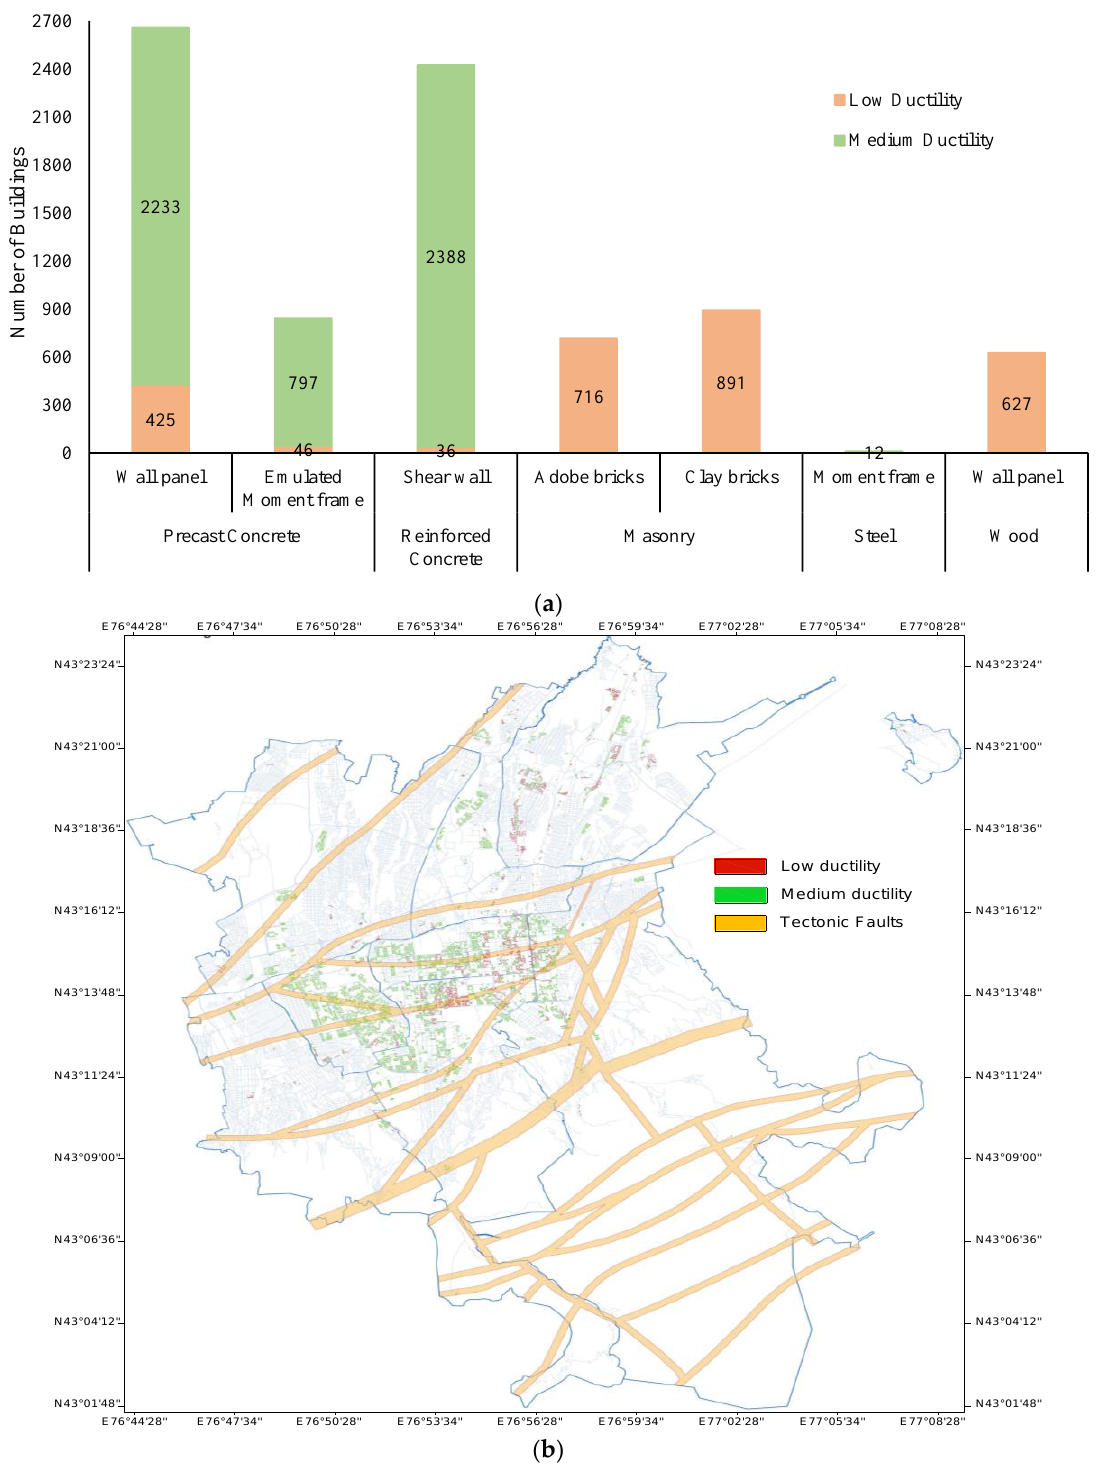
Figure 3. ( a ) Number of residential buildings in each category and ( b ) Map of Almaty with locations of the residential buildings.